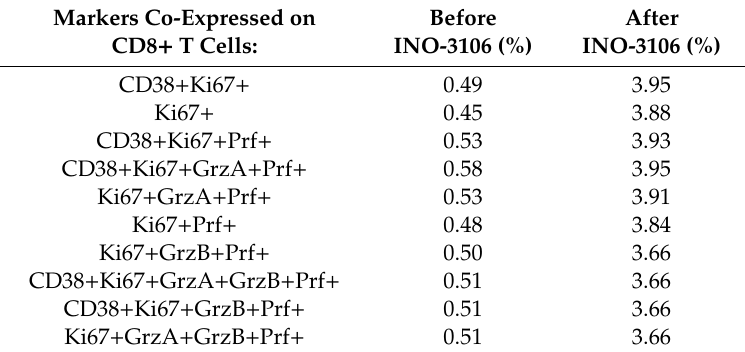
Table 1. CD8 + T Cell Phenotyping for Patient 603.